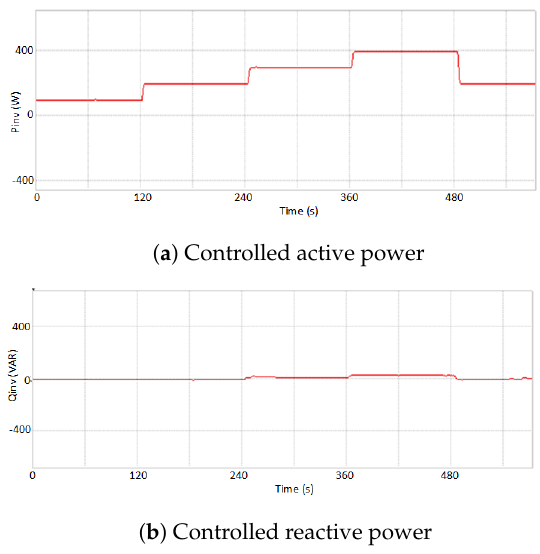
Figure 20. Active and reactive power control